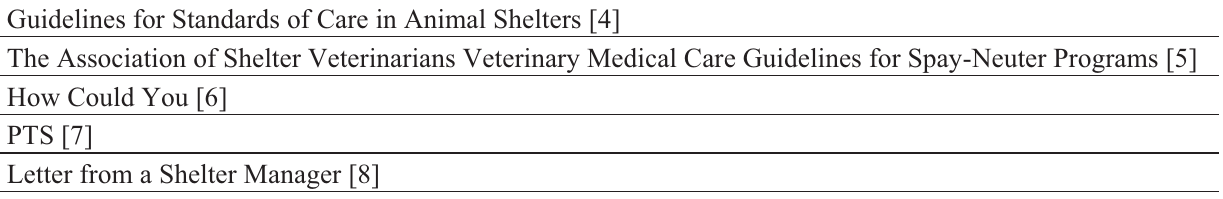
Table 3. Average number of surgeries of each type performed by senior veterinary students. Average per